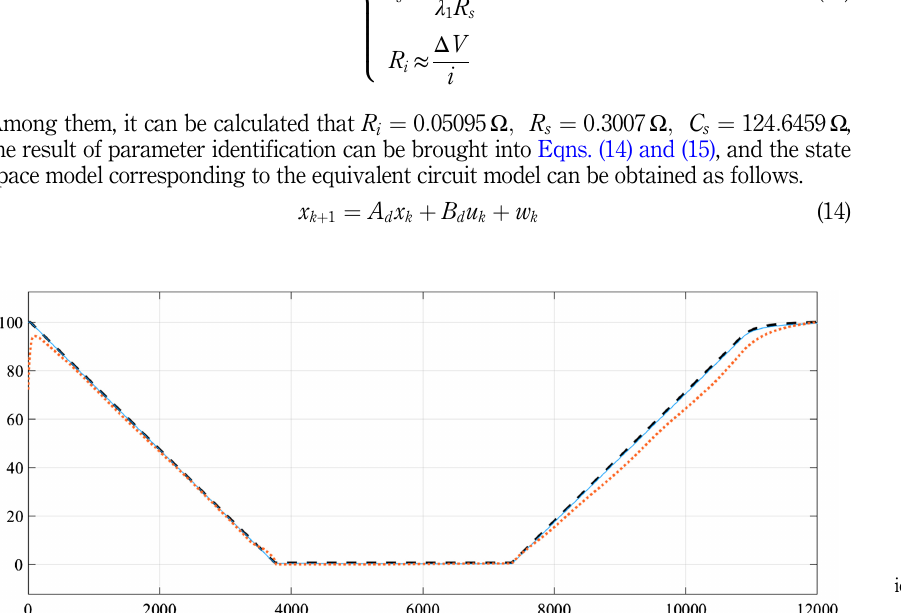
Figure 3. Voltage curve of identification